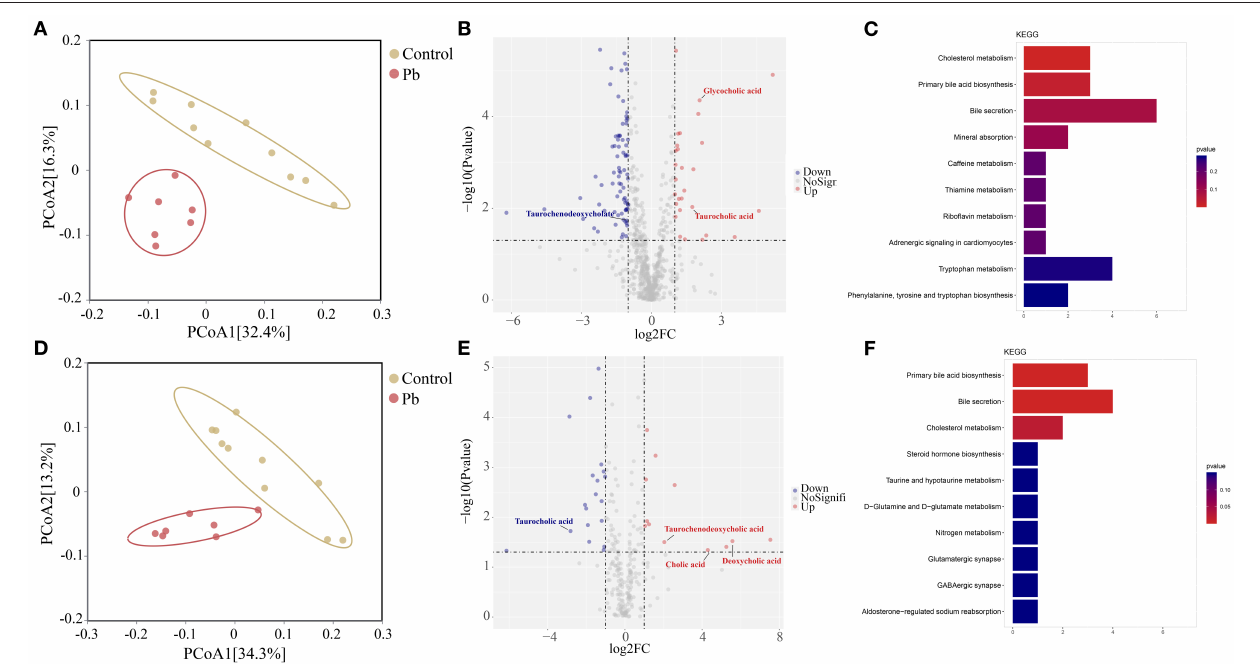
FIGURE 6 | Bile acid metabolism is changed after Pb poisoning. (A) PCoA scatterplot displaying overall metabolites composition in postive mode. (B) Valcano plot of metabolites in postive mode. (C) Dot plot of enriched KEGG pathway in the positive mode. (D) PCoA scatterplot displaying overall metabolites composition in negative mode. (E) Valcano plot of metabolites in negative mode. (F) Dot plot of enriched KEGG pathway in the negative